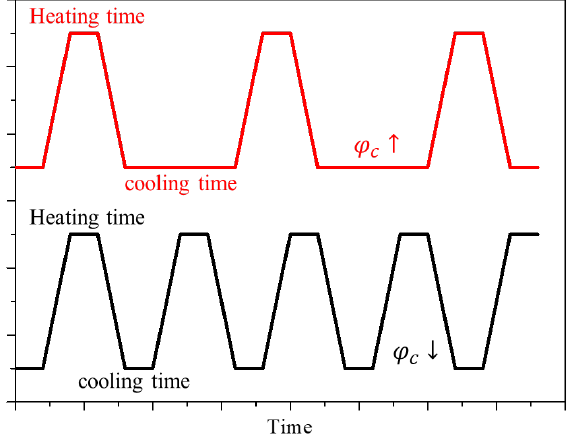
Figure 3. Cooling rate during the treatment time according to the cooling time ratio ( 𝜑 𝑐 ) change.